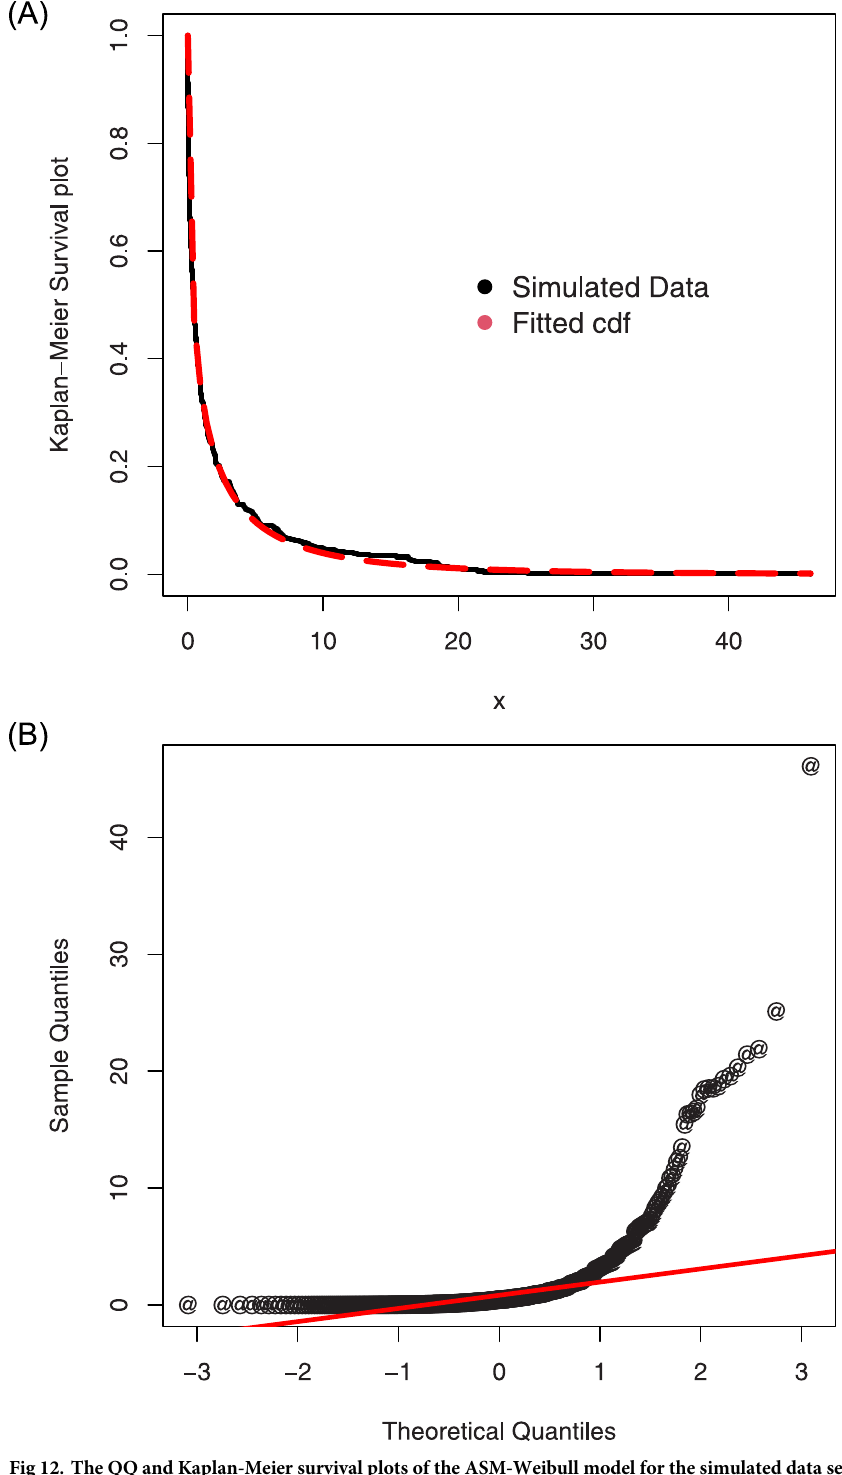
PLOS ONE | https://doi.org/10.1371/journal.pone.0254999 July 26,